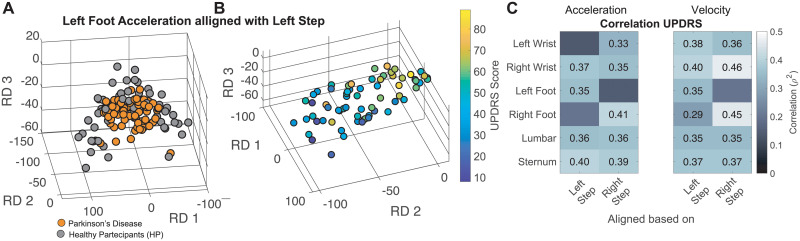
Movements in participants with PD diverge from healthy movements proportional to disease severity.A–Projection of healthy movement templates in healthy volunteers HV (gray) and PD (orange) participants. B–Projection of age matched healthy movement templates in gray and PD participants color coded according to the UPDRS score. C- Results of a linear regression model applied to the 3D of the RDS projections against the UPDRS score for each sensor aligned either with left or right step. The same analysis was repeated both for acceleration (left) and velocity (right). Only values with a p < 0.05 after correction for multiple comparisons (24: 6 sensors x 2 triggers x 2 conditions—velocity and speed) with Bonferroni method are shown.